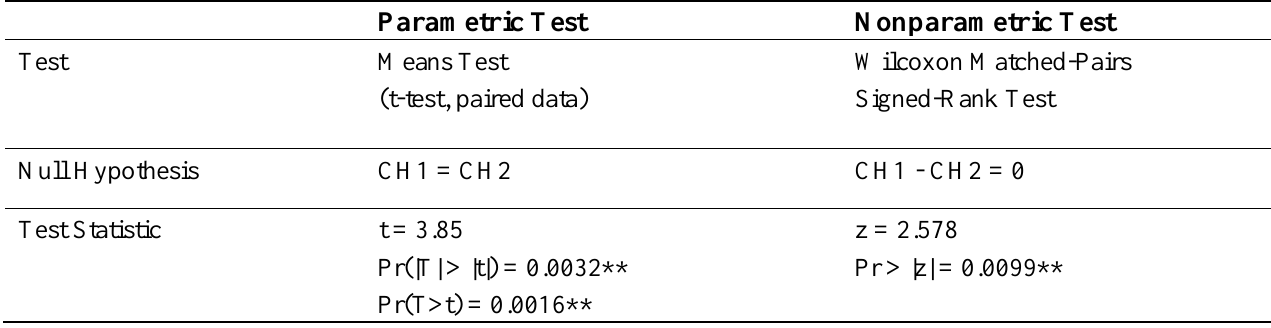
Table 3. Parametric and nonparametric tests of average Type Y response data for CH1 and